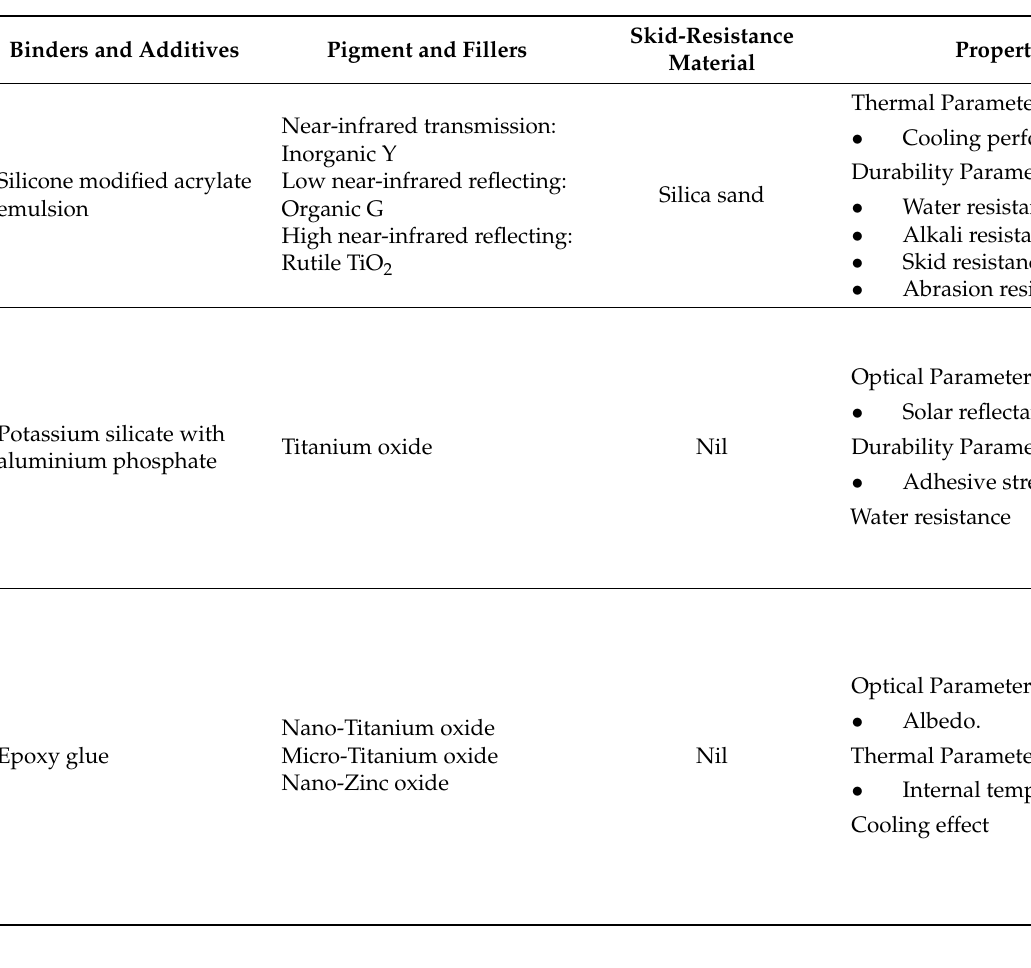
Table 2. Summary of technology investigations on coatings in the field of reflective